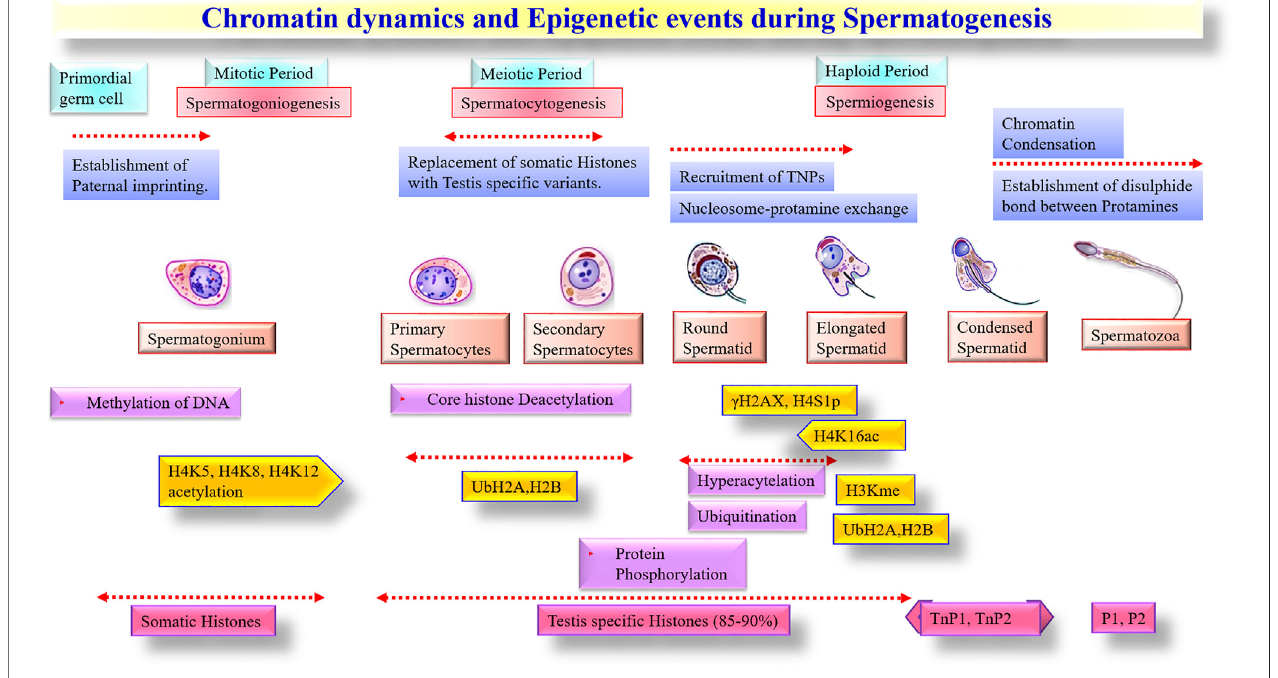
FIGURE 2 | Chromatin dynamics and Epigenetic events during